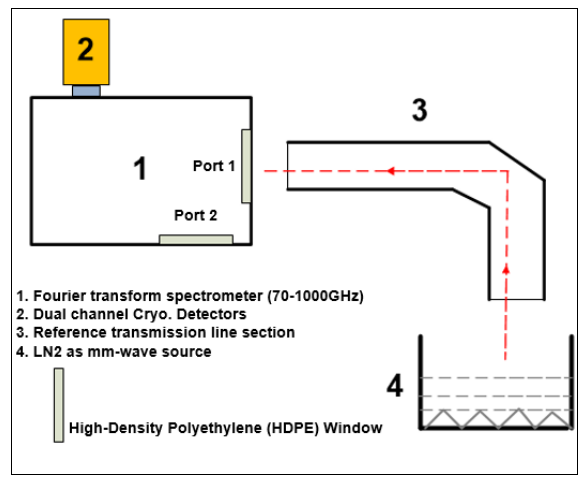
Fig. 1: Schematic of experimental set-up